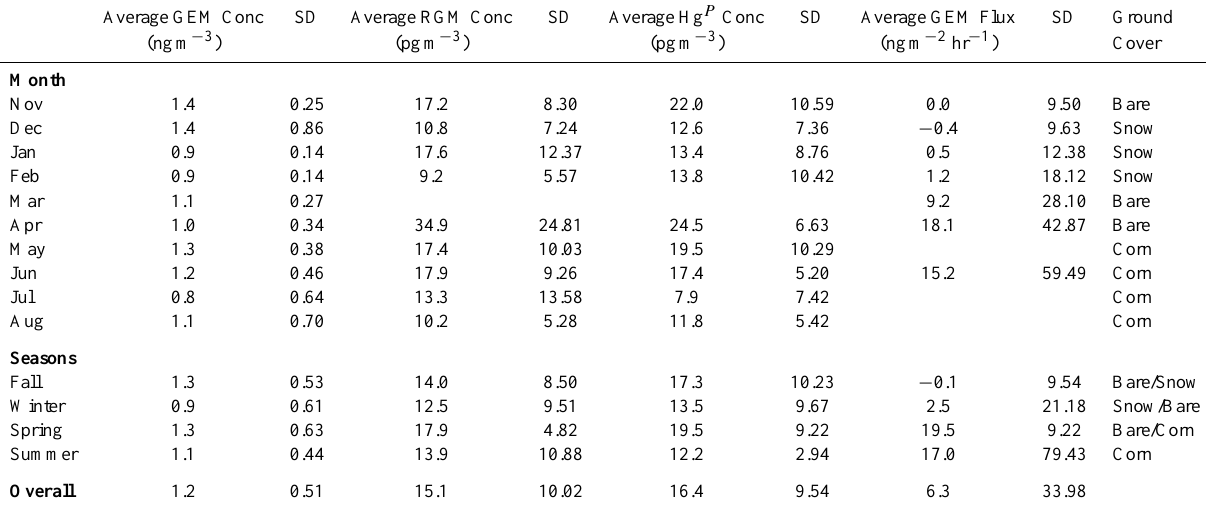
Table 3. Average monthly and seasonal Hg species concentrations and GEM flux measured at Elora, ON (November 2006–August 2007) over different ground covers.